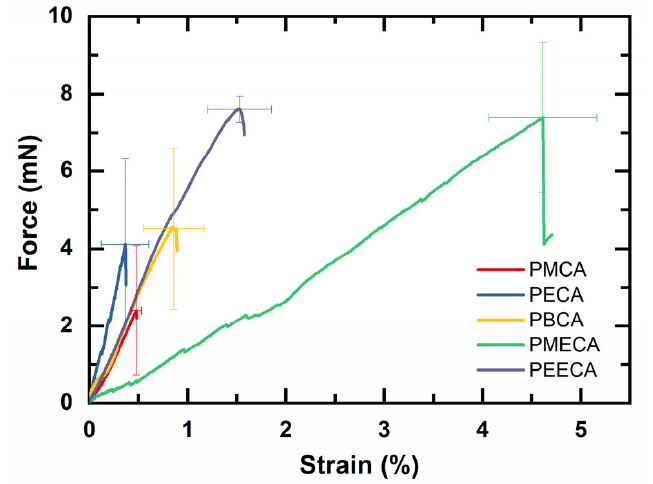
Figure 3. Force against strain of PACA membranes obtained by microindentation till breakage (typical experimental error of the force sensor probe is 0.5 mN). Data represented as mean ± SD ( n =